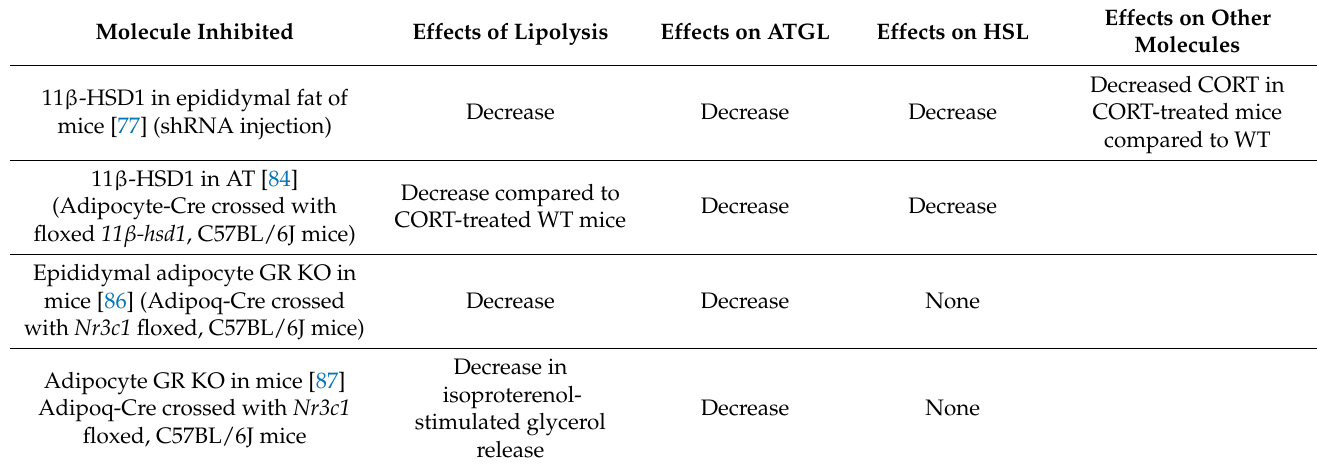
Table 1 includes a summary of loss of function studies in WAT. Table 1. Summary of loss of GC function studies on lipolysis in